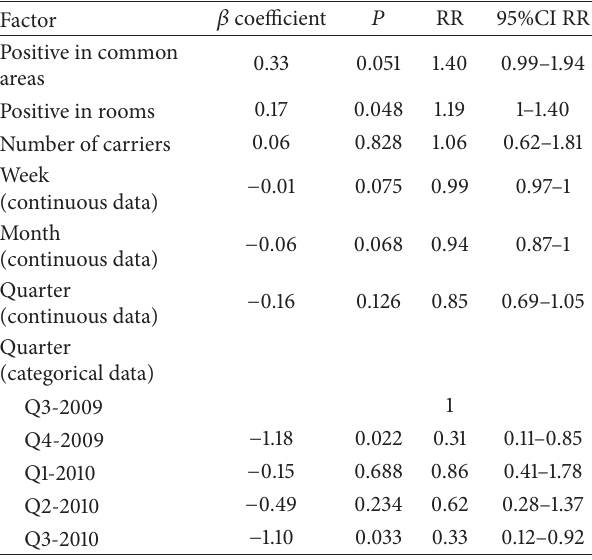
Table 3: Poisson regression analysis of different factors involved in the outbreak (univariate